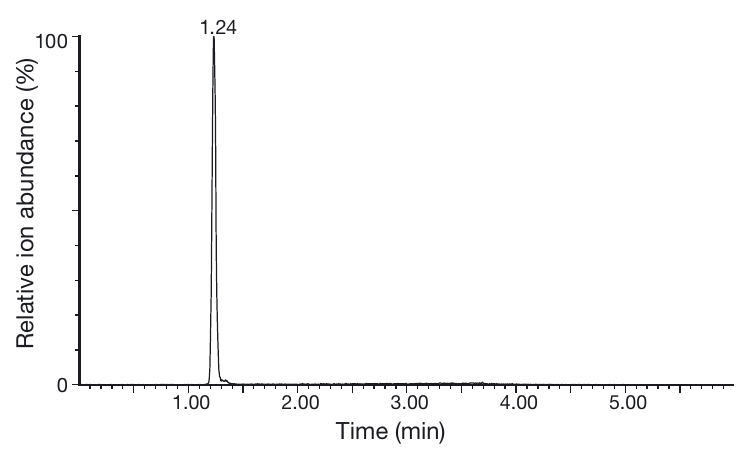
Fig. 1. Liquid chromatography-mass spectograph of methomyl showing the total ion mass spectrum. Concentration of methomyl is 20 µg l